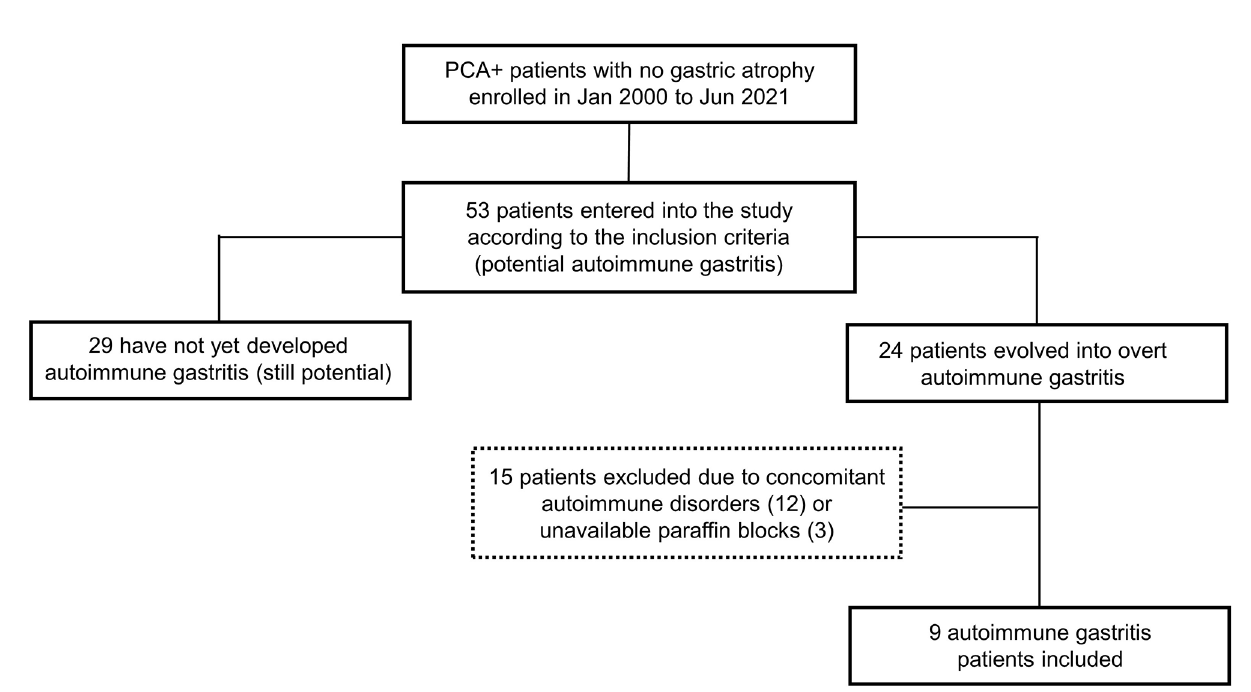
FIGURE 1 | Flowchart showing the selection of patients with potential autoimmune gastritis (AIG). Over the study period, 53 patients turned out to have serum anti- parietal cell antibodies (PCA) and no gastric atrophy. Of these, at follow-up, 24 developed overt AIG, de fi ned as the occurrence of any grade of atrophy in the oxyntic mucosa. For the purposes of the present study, we excluded potential AIG patients with concurrent autoimmune disorders (12 cases), as well as patients in whom the gastric paraf fi n blocks were not available (3 cases). Hence, nine potential AIG patients were eventually